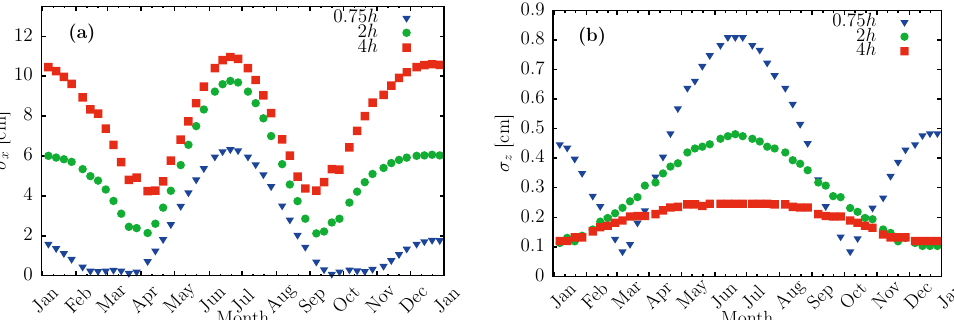
Figure 6. Daily standard deviation of facet impact points in x ( a ) and z ( b ), for H4 arrays located at 0.75 h (26.25 m), 2 h (70 m), and 4 h (140